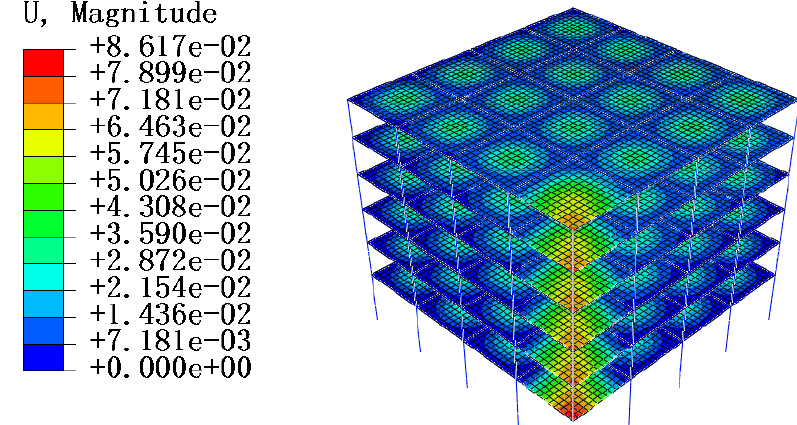
Figure 11. The most unfavorable combination displacement diagram of the bottom corner column.